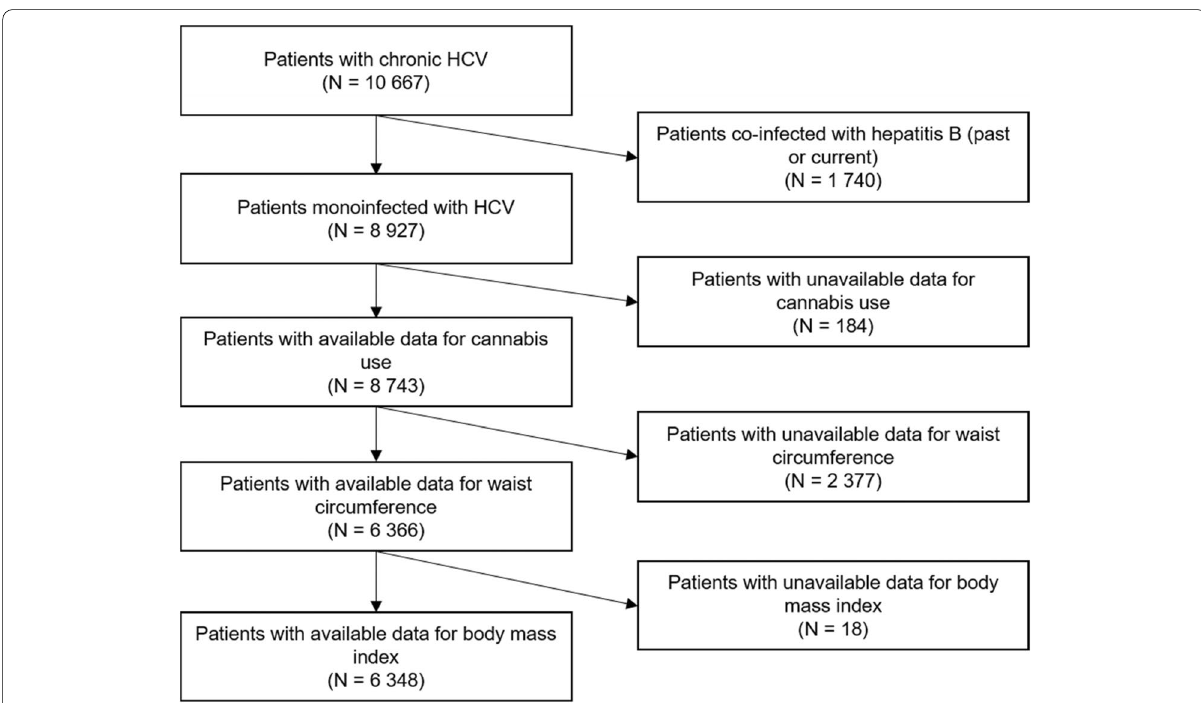
Fig. 1 Flow chart of the study population (ANRS CO22 Hepather